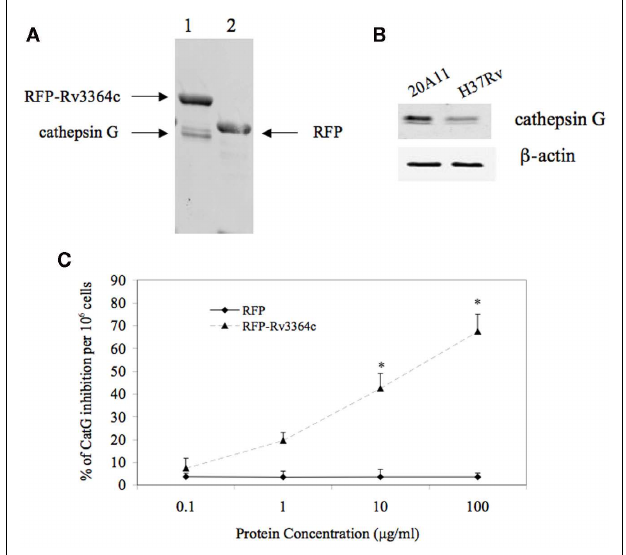
FIGURE 5 | Host target protein for Rv3364c. (A) The His-paramagnetic pre-charged nickel-pulling assay of macrophage proteins interacting with M. tuberculosis Rv3364c identified 29kDa plasma-membrane-associated serine protease cathepsin G. (1) His-tag-RFP–Rv3364c pull-up sample with cathepsin G; (2) His-tag-RFP control pull-up sample. (B) Cathepsin G protein expression levels byWestern blot analysis: (1) 20A11 mutant infection; (2) M. tuberculosis H37Rv infection. (C) The effects of the Rv3364c protein on cathepsin G activity. Purified His-tag-RFP–Rv3364c protein was exposed for 4h to pre-cleared macrophage lysates at 0.1–100 μ g/ml concentration range and changes in cathepsin G activity were measured as% of cathepsin G inhibition per 10 6 cells.The data represent the average of three independent experiments ± SD. * p < 0.05 for the comparison between His-tag-RFP– Rv3364c experimental and His-tag-RFP control treatments at the same concentration of proteins.